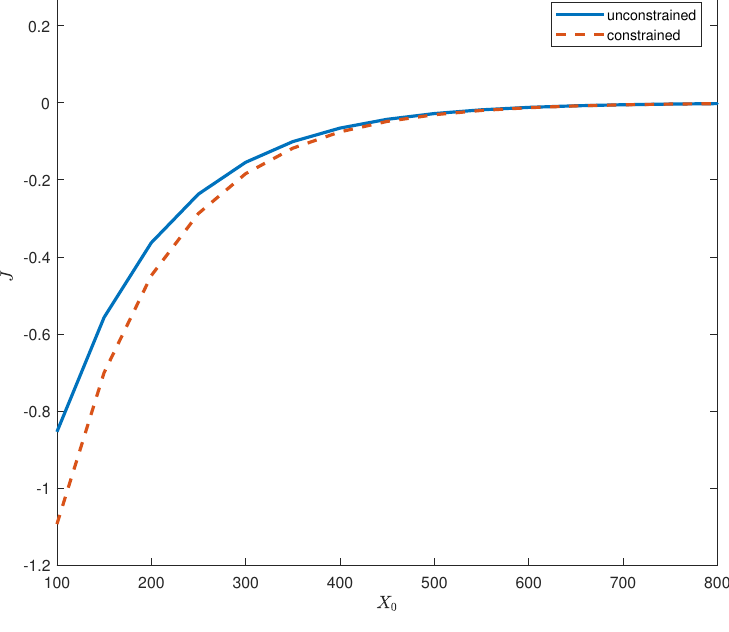
Figure 9. Value function J as a function of initial wealth X 0